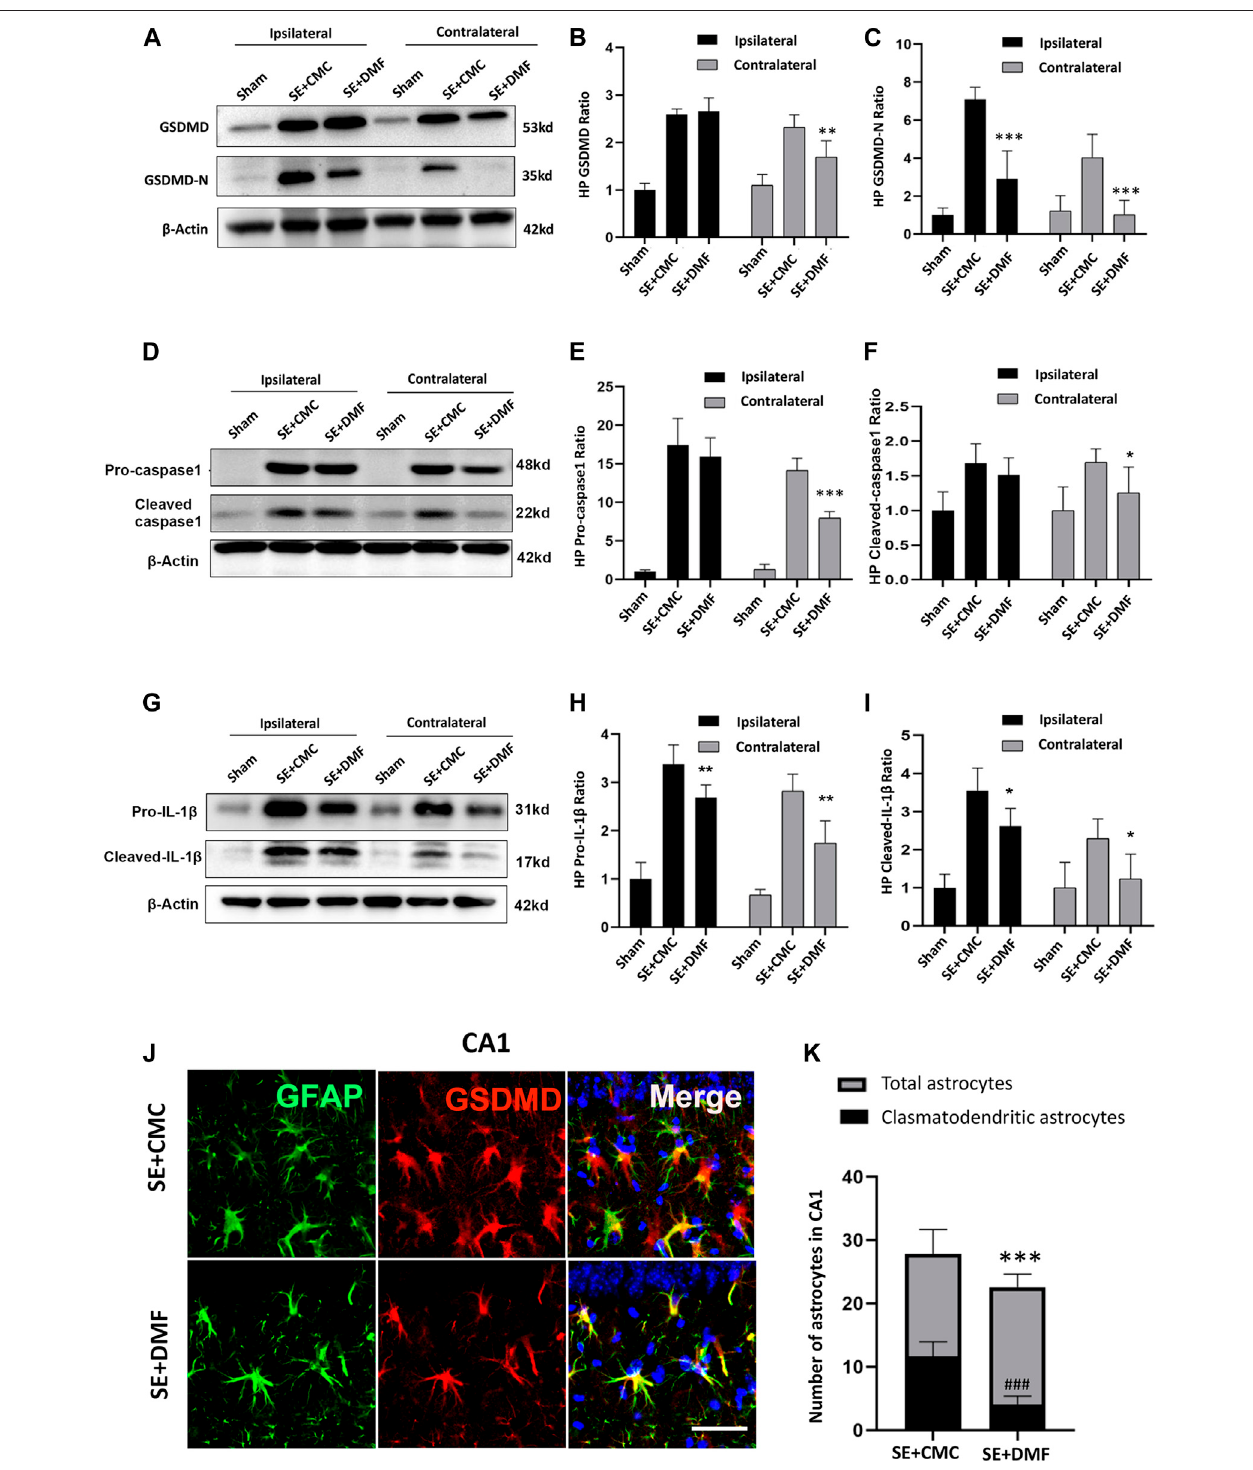
FIGURE 3 | DMF intervention inhibited the expression of GSDMD-N and attenuated astrocytic clasmatodendrosis. (A – C) WB bands and statistical analyses of GSDMD, GSDMD-N, and β -actin proteins in the ipsilateral and contralateral hippocampus in the SE + CMC and SE + DMF groups (n (cid:1) 6 in each group, asterisks represent the comparison with the SE + CMC group, * p < 0.05, ** p < 0.01, and *** p < 0.001). (D – F) WB bands and statistical analyses of pro-caspase-1, cleaved- caspase1,and β -actinproteinsintheipsilateralandcontralateralhippocampus(n (cid:1) 6ineachgroup,asterisksindicatethecomparisonwiththeSE+CMCgroup,* p < 0.05, ** p < 0.01, and *** p < 0.001). (G – I) WB bands and statistical analyses of pro-IL-1 β , cleaved – IL-1 β , and β -actin proteins in the ipsilateral and contralateral